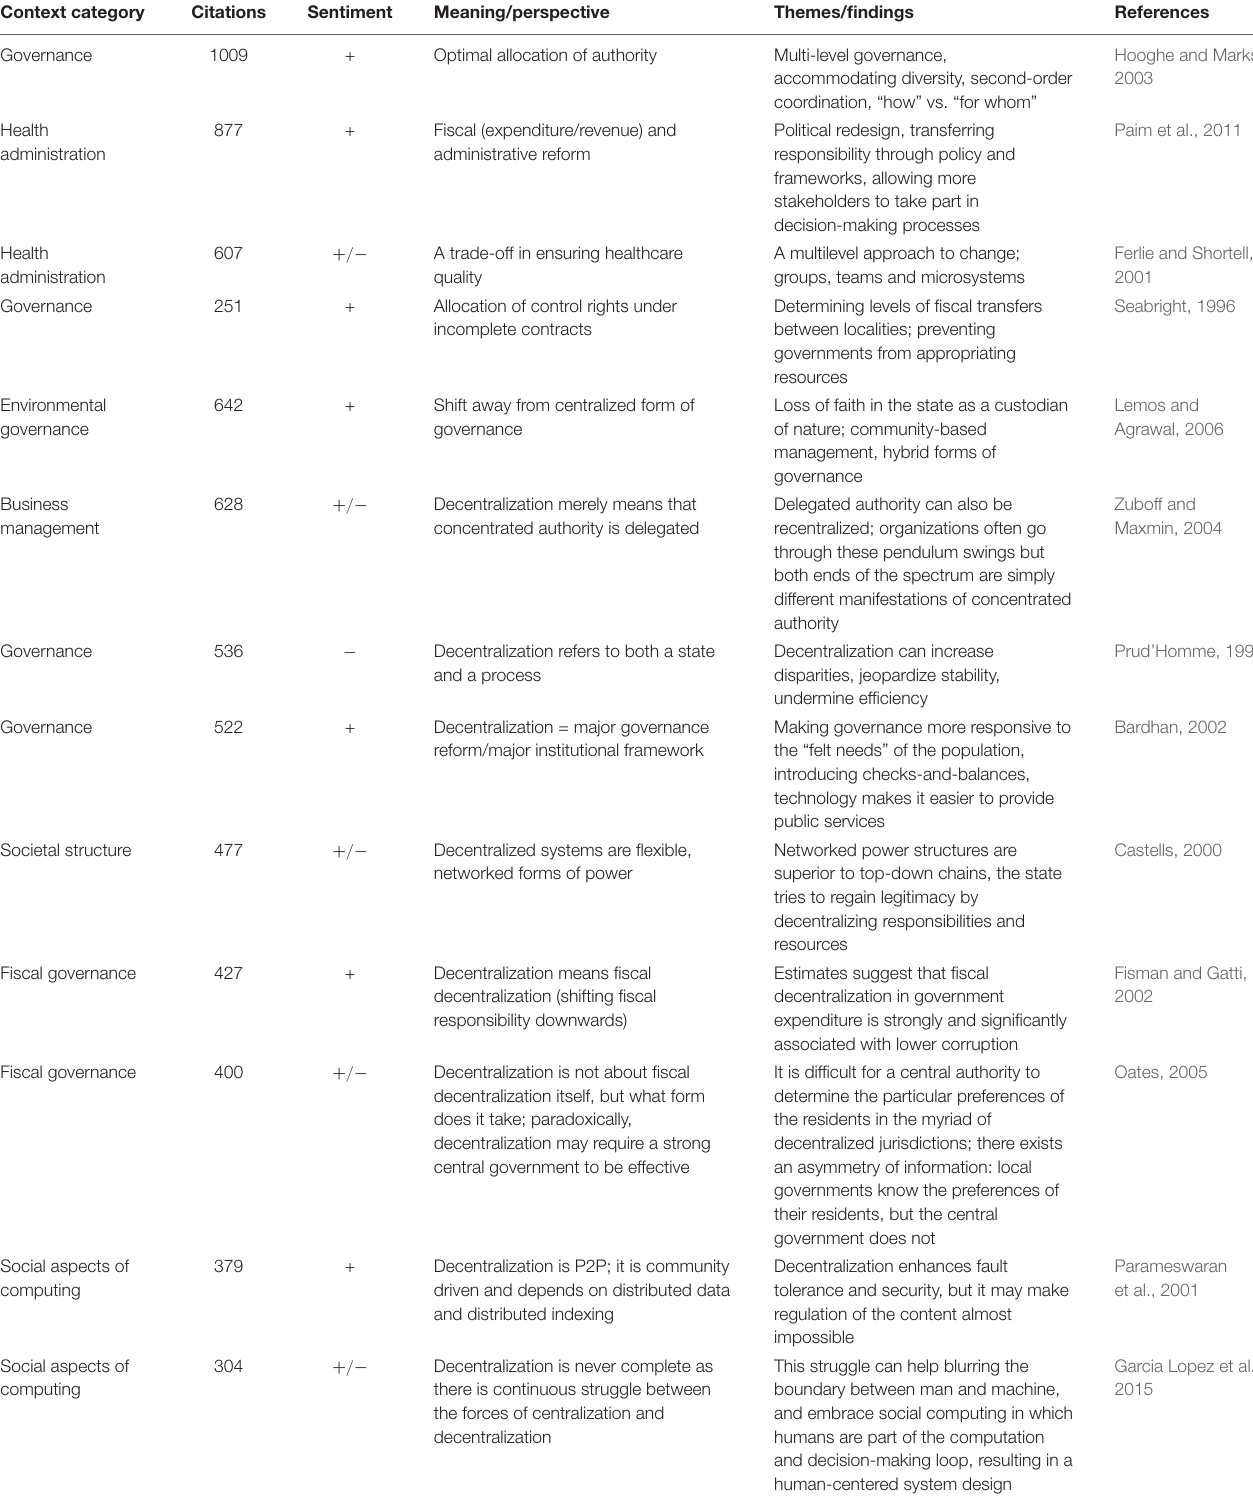
TABLE 1 | Most relevant mentions of decentralization across non-blockchain contexts ordered by citation